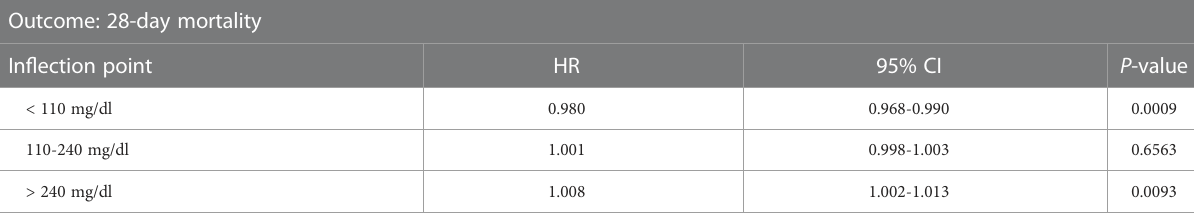
TABLE 3 Threshold effect analysis of glucose level and 28-day mortality rate using piece-wise linear regression. Outcome: 28-day mortality